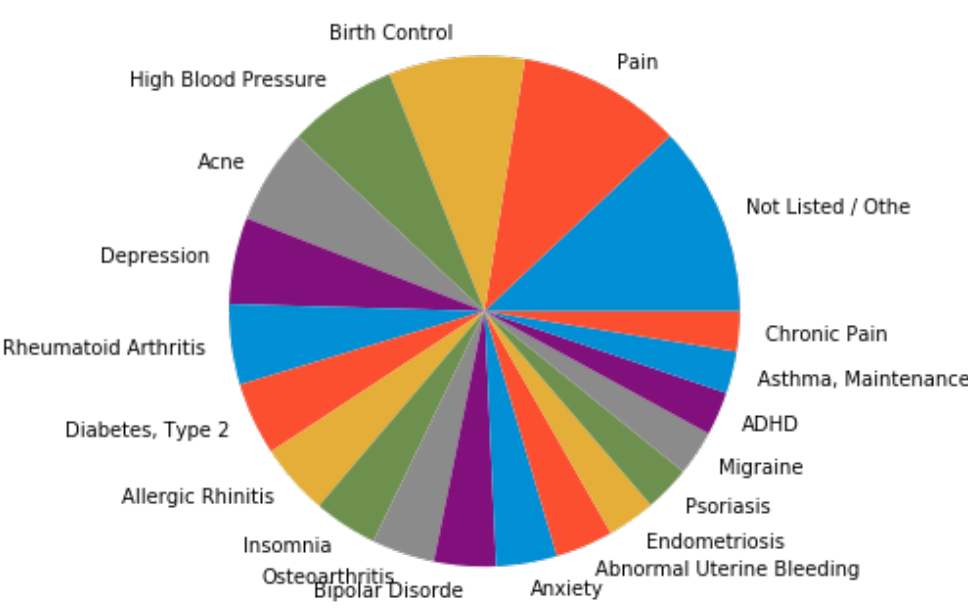
Figure 6. Top rated conditions and their weight in